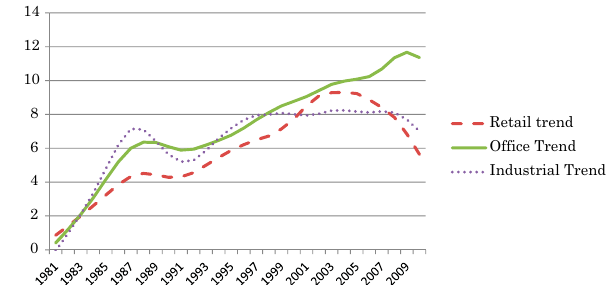
fig. 7. Trends in sales as a percentage of capital value of the stock based on the HP filter ( λ = 6.25)